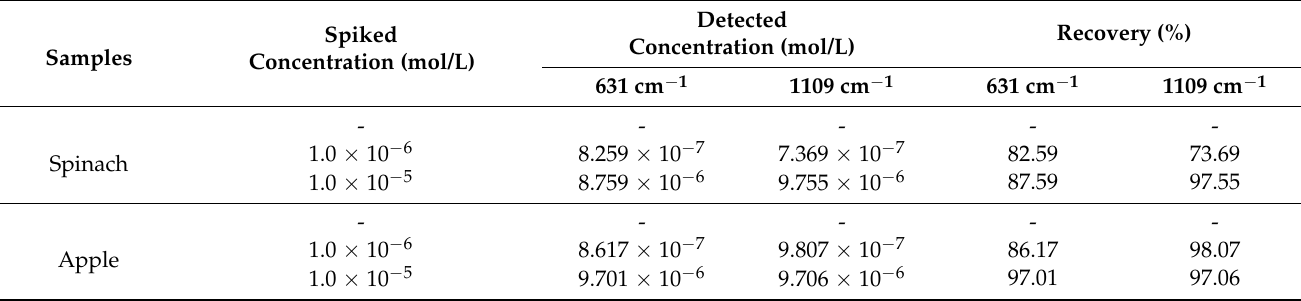
Table 2. Determination of acetamiprid in spiked spinach and apple using the developed SERS method. Spiked Samples Concentration (mol/L)